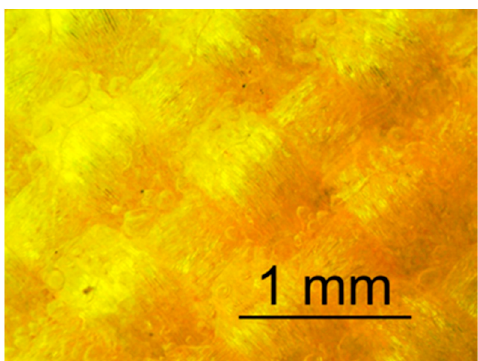
Figure 2. Microscopic image of the surface of the composite substrate on which the analyzed metallic layer was deposited (Optical SZ 630-T optical microscope with a magnification of 80 times).